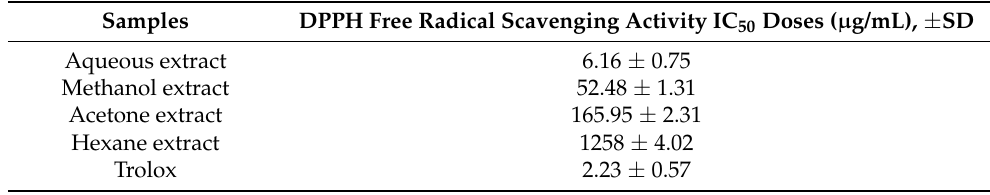
Table 5. DPPH free radical scavenging activity of H. lanuginosum extracts and Trolox. Samples